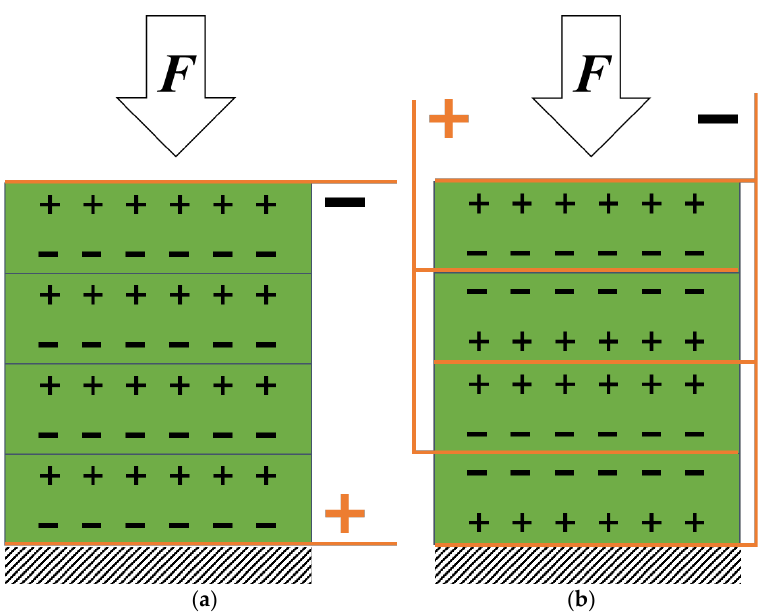
Figure 3. Connection mode of multilayer stacked piezoelectric ceramics. ( a ) Series connection mode; ( b ) parallel connection mode.